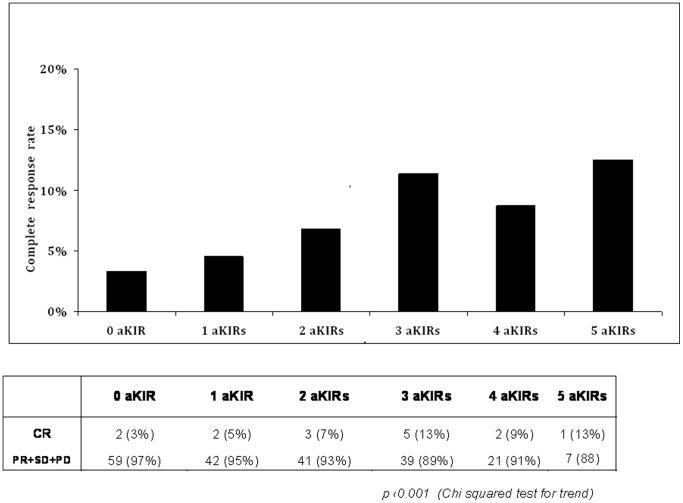
Association between the number of activating KIR (aKIR) genes and complete response (CR) rate.The KIR gene analysis shows a trend (chi squared test for trend, p<0.001) between an increasing number of aKIR genes (KIR2DS3 and KIR2DS5; ligand unknown) or aKIR/HLA-ligand (KIR2DS1/HLA-C2, KIR2DS2/HLA-C1, KIR2DS4full/HLA-Cw*04, KIR3DS1/HLA-Bw4) and the rate of CR.